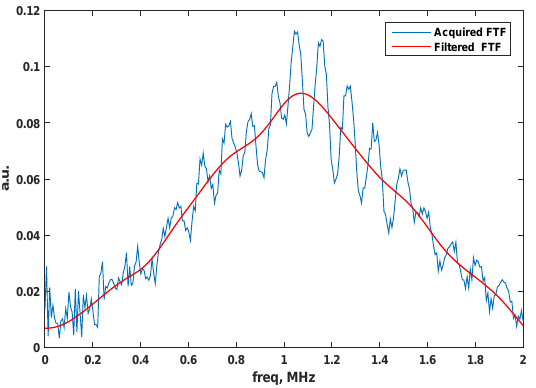
Figure 3. The acquired frequency transfer function (FTF) (blue) and the filtered one (red) at a given spatial